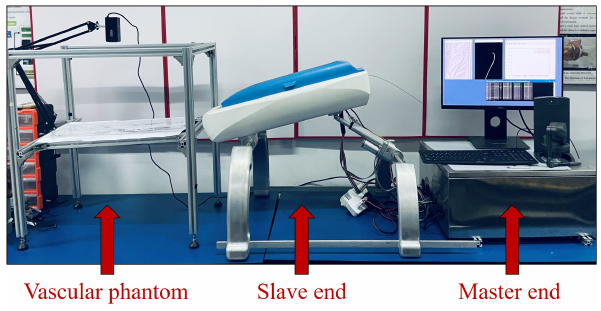
Figure 2. The robot experimental